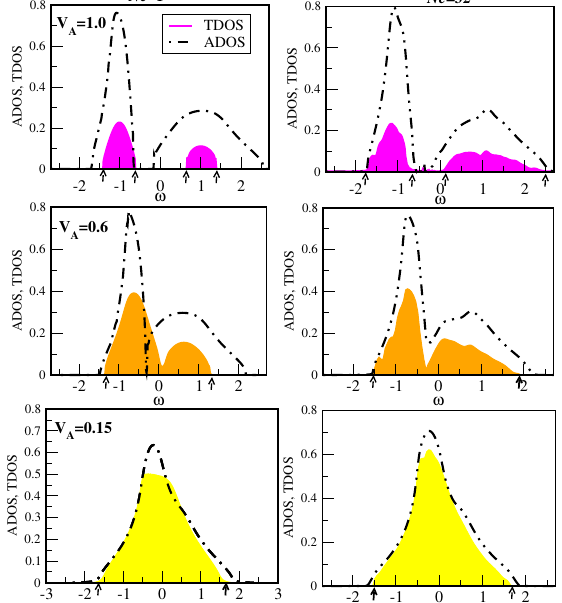
Figure 33. ADOS and TDOS of the A-B binary alloy model with off-diagonal disorder. The left panel displays results for the TMT N c = 1 and the right panel for the TMDCA with N c > 1. The average DOS (dash-dotted line) and the TDOS (shaded regions) for N c = 1 (left panel), N c = 4 3 (right panel) and blue dash lines for N c = 5 3 (left panel) for various values of the local potential V A with off-diagonal disorder parameters: t AA = 1.5, t BB = 0.5, t AB = 0.5 ( t AA + t BB ) , and c A = 0.5. We show the TDOS for several cluster sizes N c = 1, 4 3 , and = 5 3 to show its systematic convergence with increasing cluster size N c . The ADOS converges within our numerical precision for cluster sizes beyond N c = 4 3 . The TDOS is finite for the extended states and zero for localized states. Reprint from